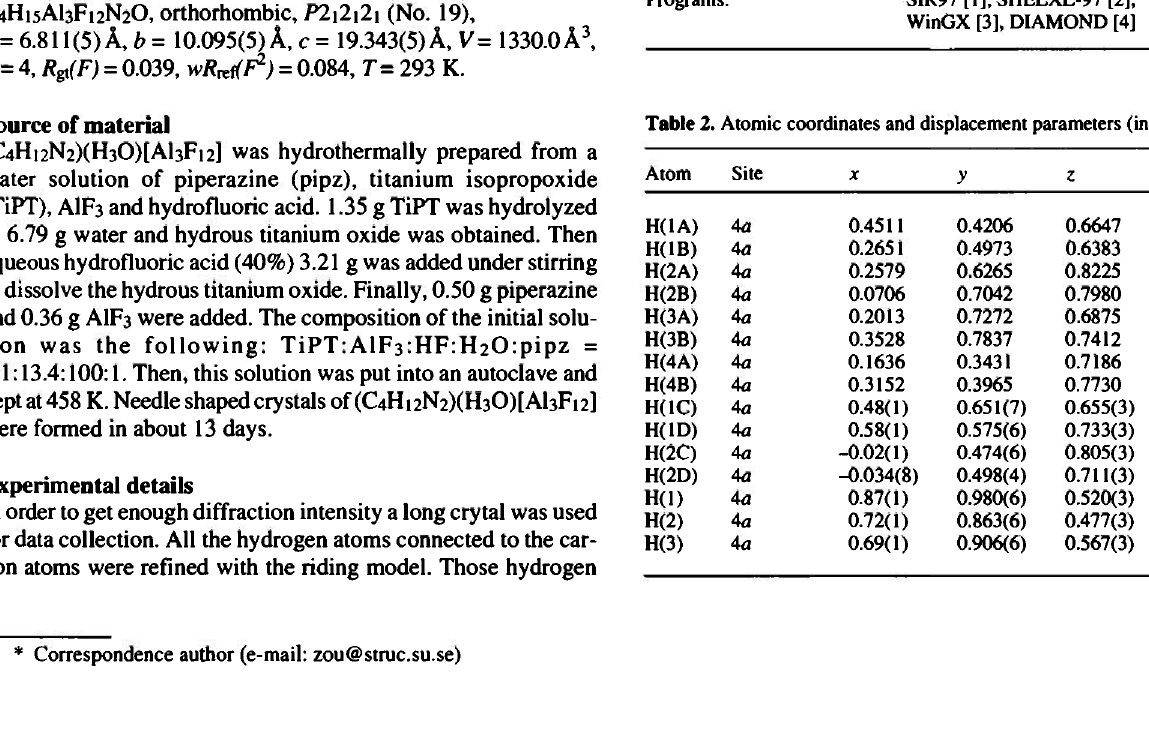
Table 1. Data collection and handling. Crystal: